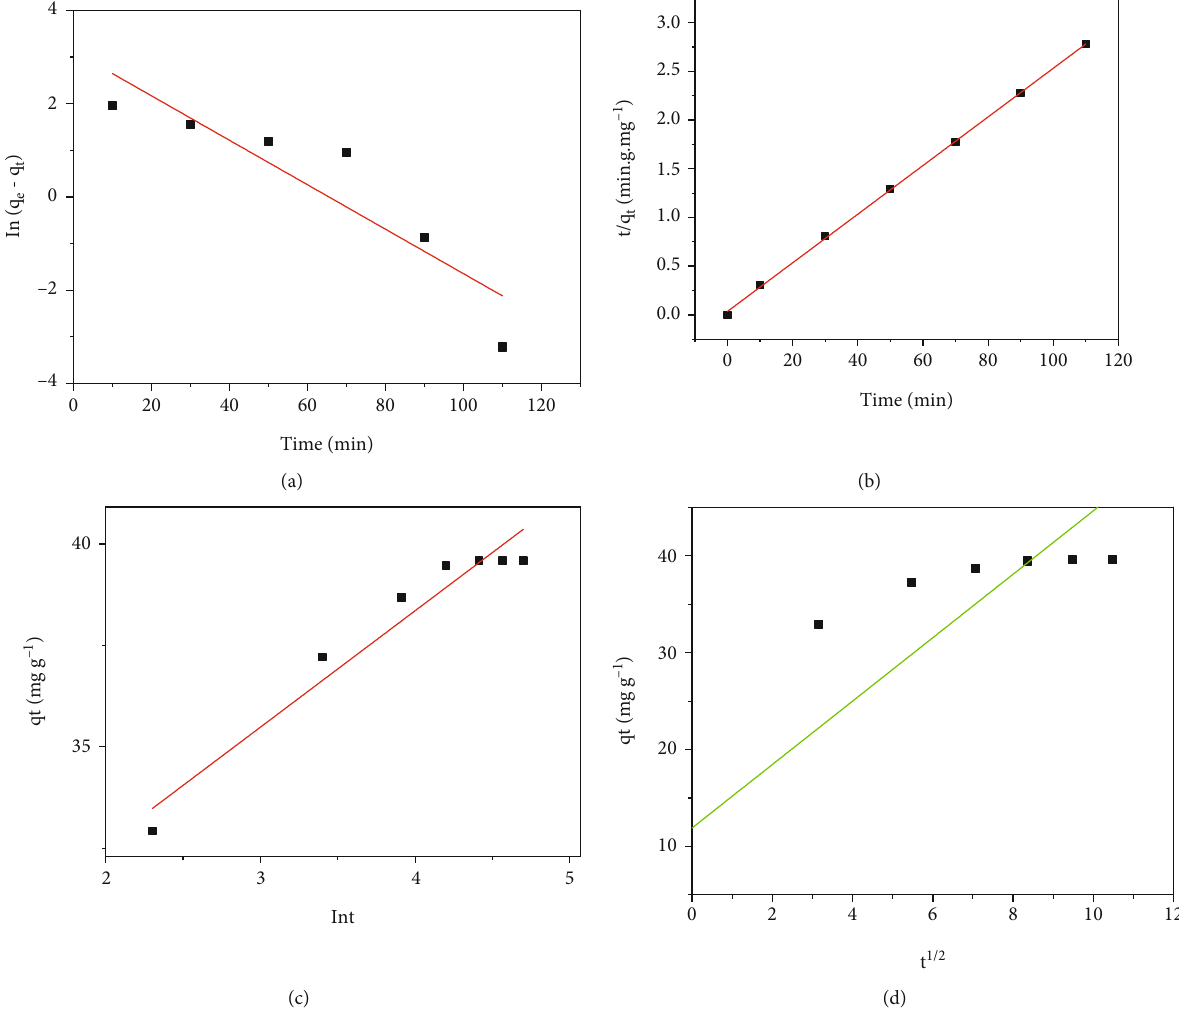
Figure 4: Kinetic models of CIP adsorption onto MBC. (a) Pseudo- fi rst-order, (b) pseudo-second-order, (c) Elovich, and (d) intraparticle models. Table 5: Isotherm models and values of their parameters. Langmuir